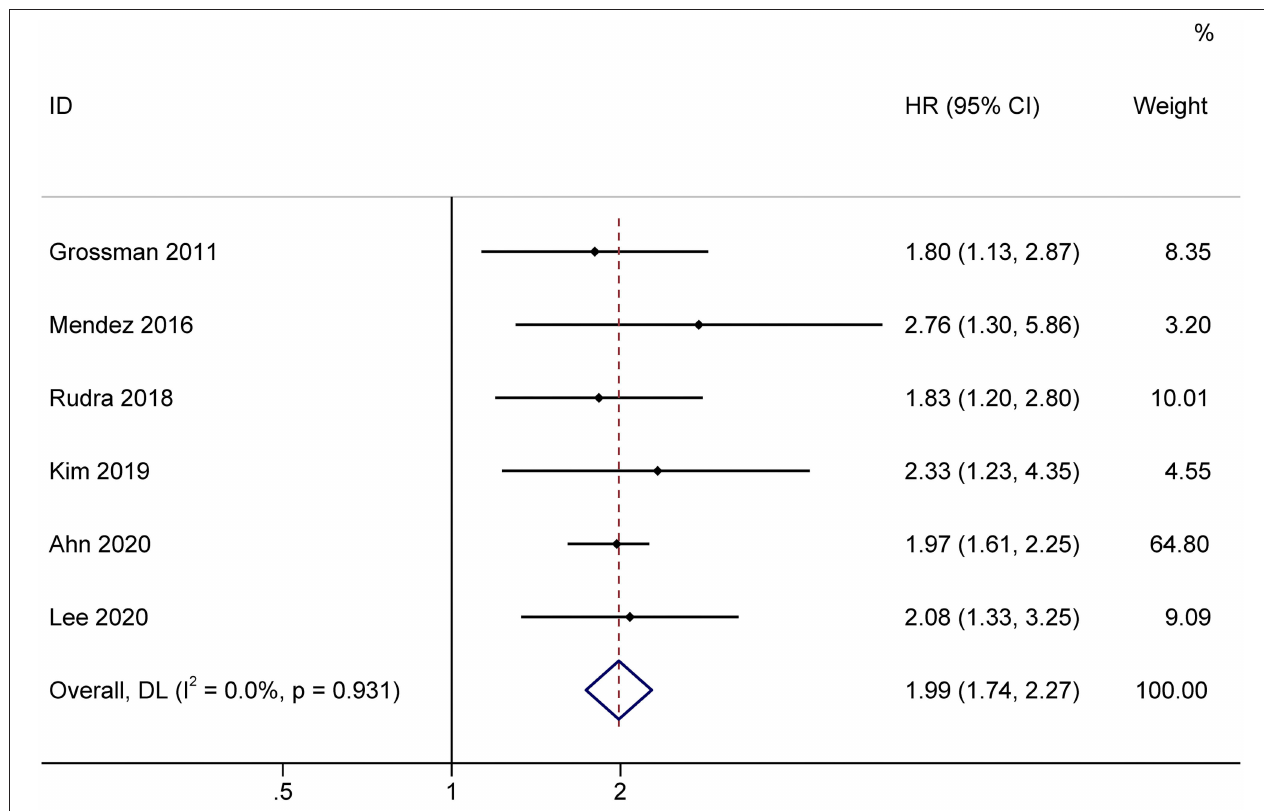
FIGURE 5 | Forest plots of the prognostic impact of treatment-related lymphopenia on overall survival in glioma patients. HR, hazard ratio; CI, confidence Interval. Weights are from random-effects